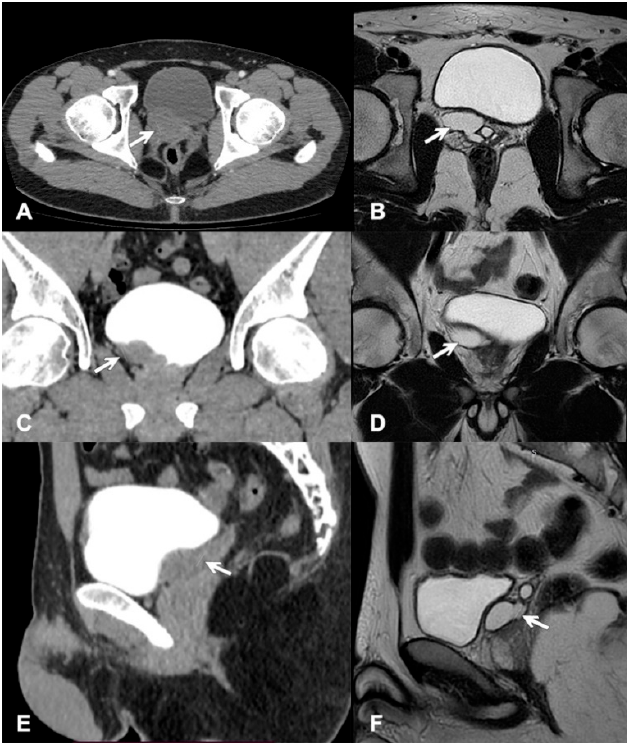
Figure 2. Enlarged seminal vesicle is pointed by the white arrow: ( A ) CT axial plane, ( B ) MRI axial plane, ( C ) CT frontal plane, ( D ) MRI frontal plane, ( E ) CT longitudinal plane, and ( F ) MRI longitudinal plane.